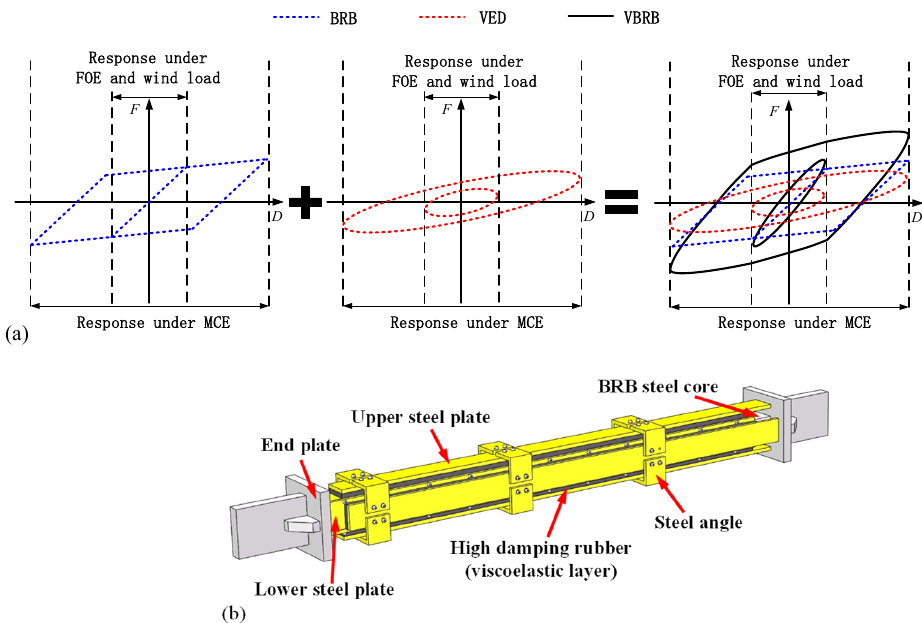
Figure 1. Simplified hysteretic model and construction details of a VBRB: ( a ) restoring force models for BRB, VED and VBRB; and ( b ) construction details of a VBRB.